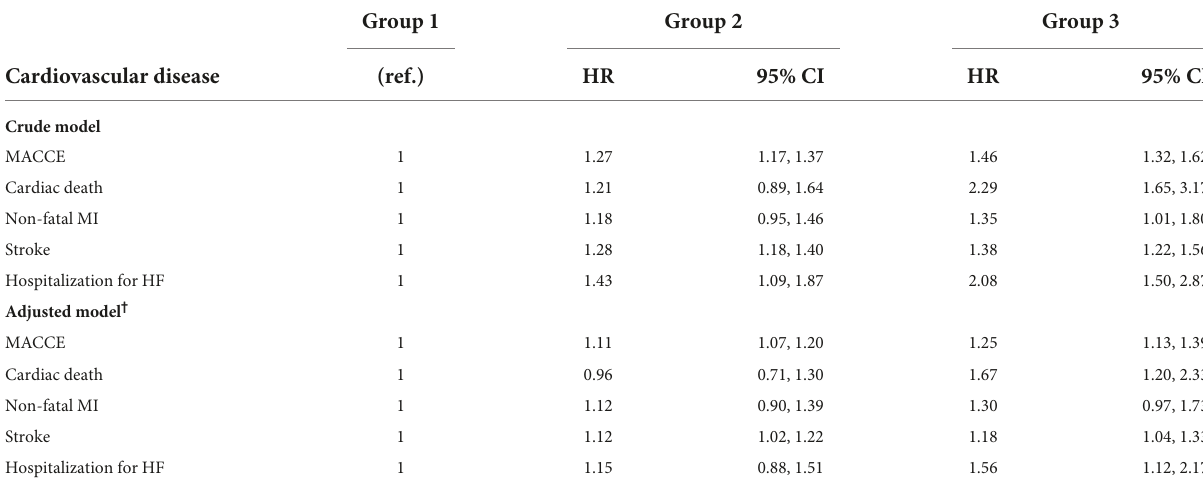
TABLE 3 Hazard ratios of adverse cardiovascular and cerebral events per the annual height decrease